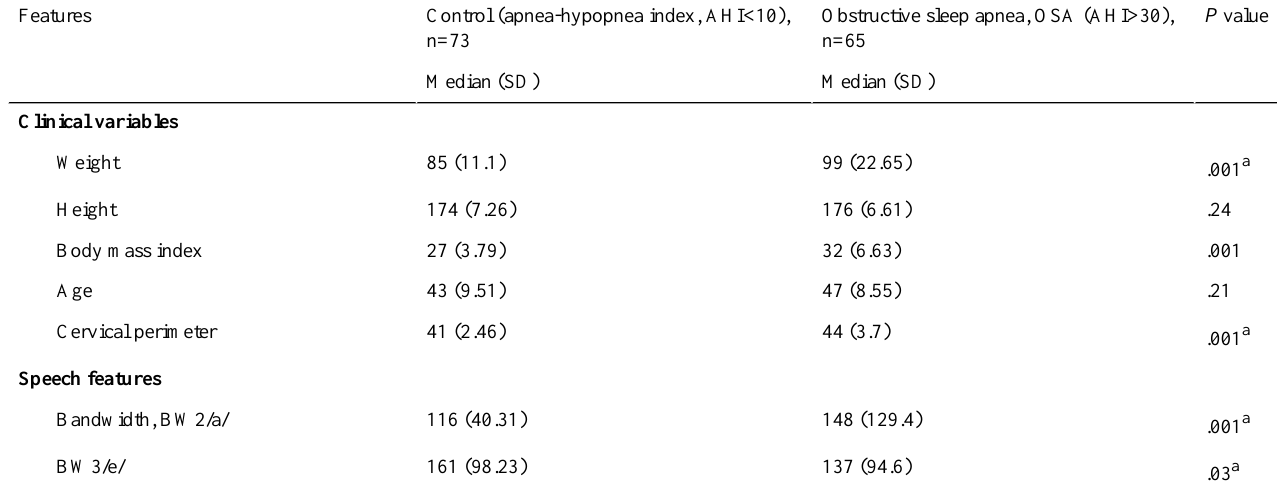
Table 13. Contrast between control and obstructive sleep apnea (OSA) groups on a subset without differences either on age or on height on the male